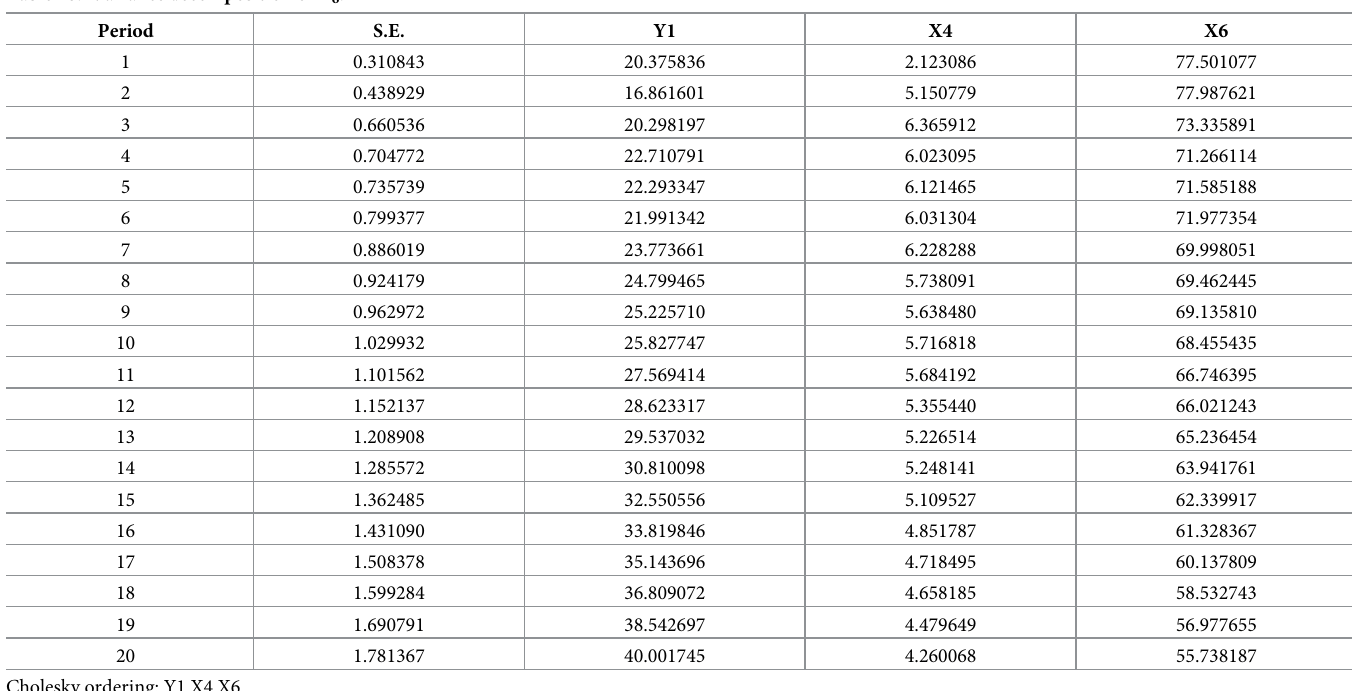
Table 10. Variance decomposition of X 6